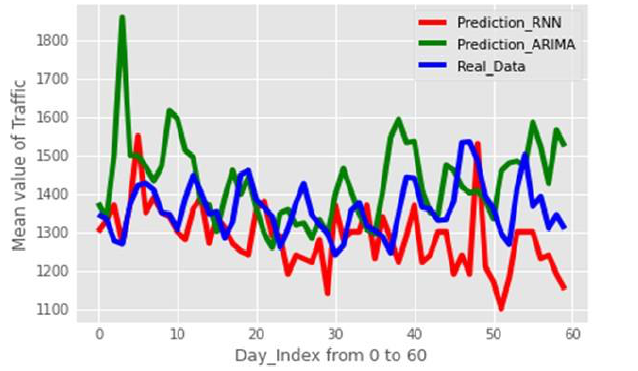
Figure 8. RNN predictor and ARIMA predictor for 300 training samples.